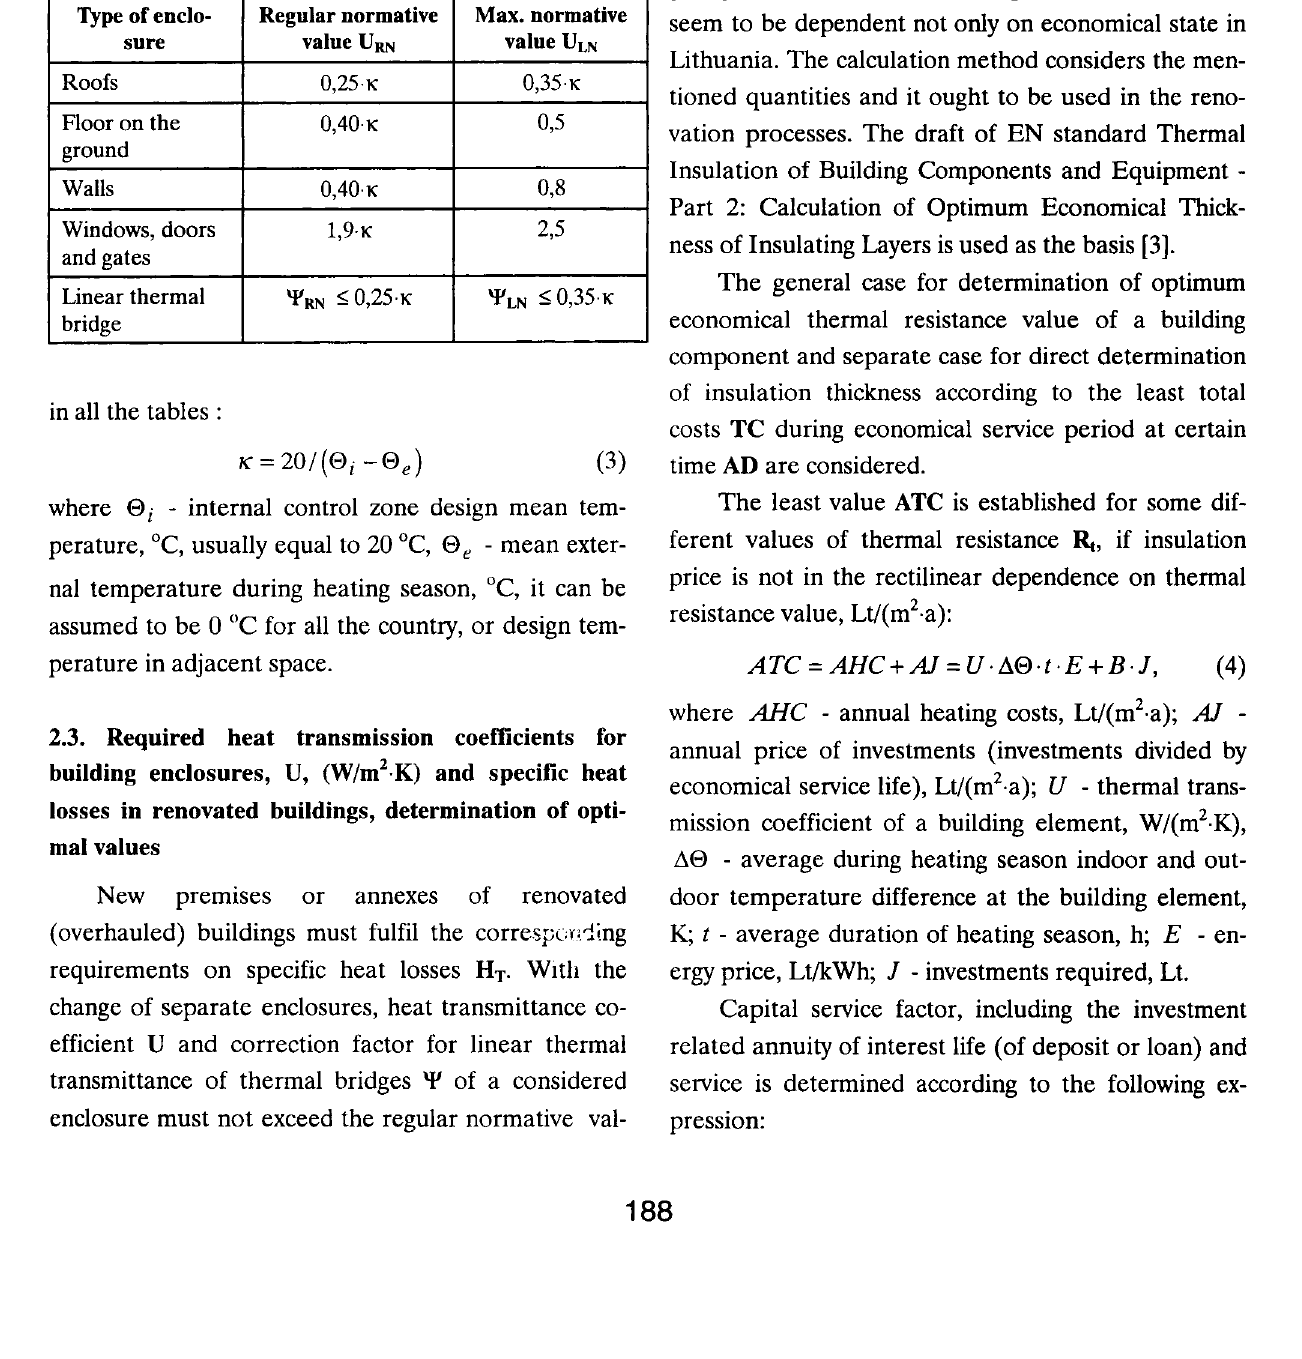
Table 4. Required values for heat transmittance coefficient U, W/(m 2 ·K) and correction factor of linear thermal bridge \jf, W/(m·K) in industrial buildings Type of enclo- Max.